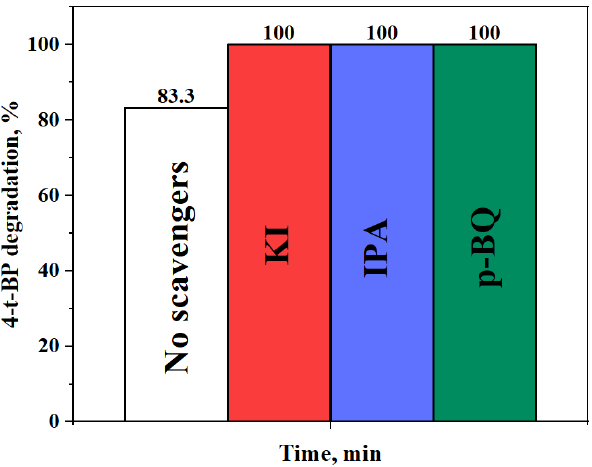
Figure 9. Effect of KI, IPA, and p-BQ on the degradation of 4-t-BP. Experimental conditions: [4-t- BP] 0 = 5 ppm, catalyst dosage = 200 mg/L. [4-t-BP] 0 = 5 ppm, catalyst dosage = 200 mg/L.